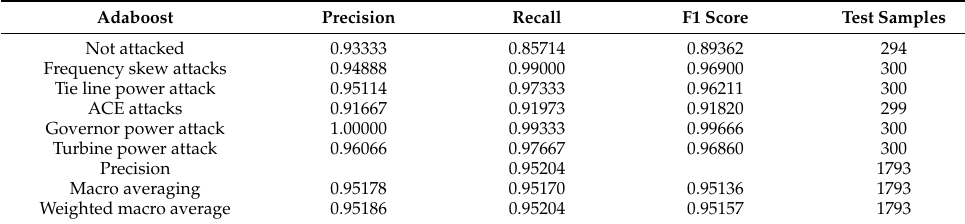
Table A6. The Adaboost algorithm trained on model metric data. Adaboost